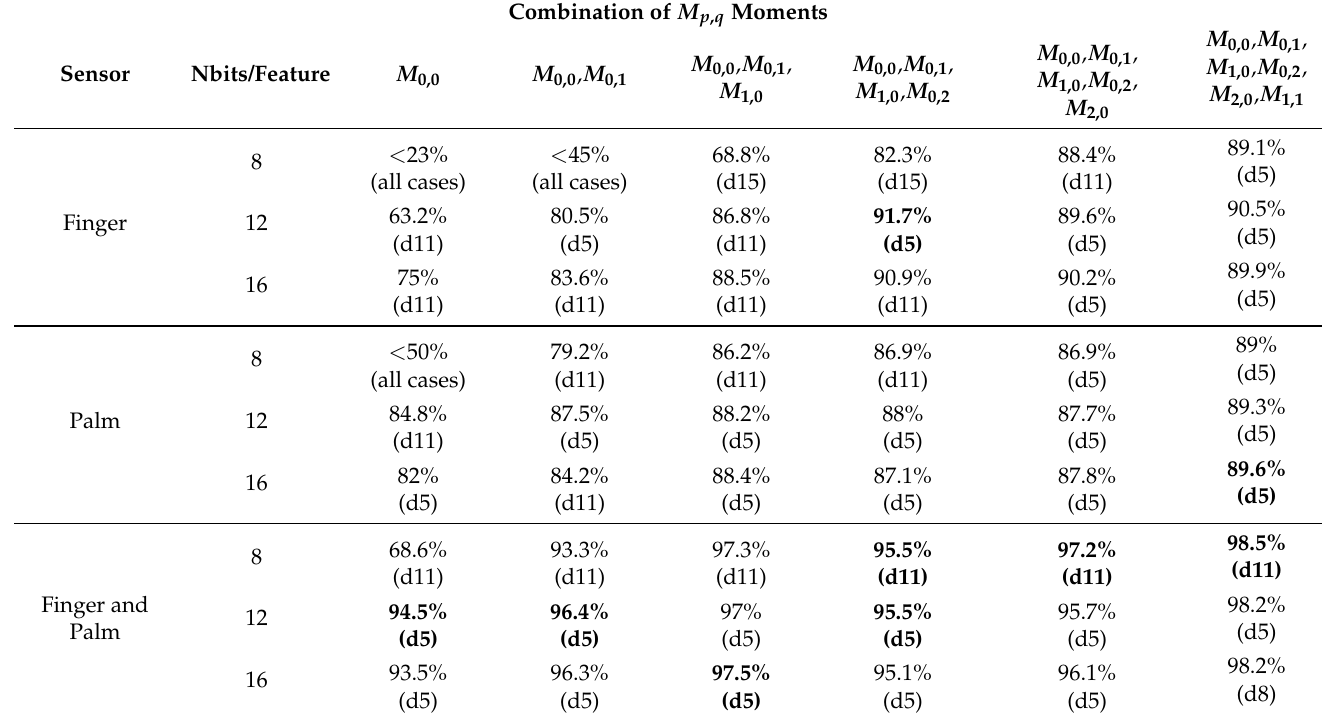
Table 3. Classification accuracy without